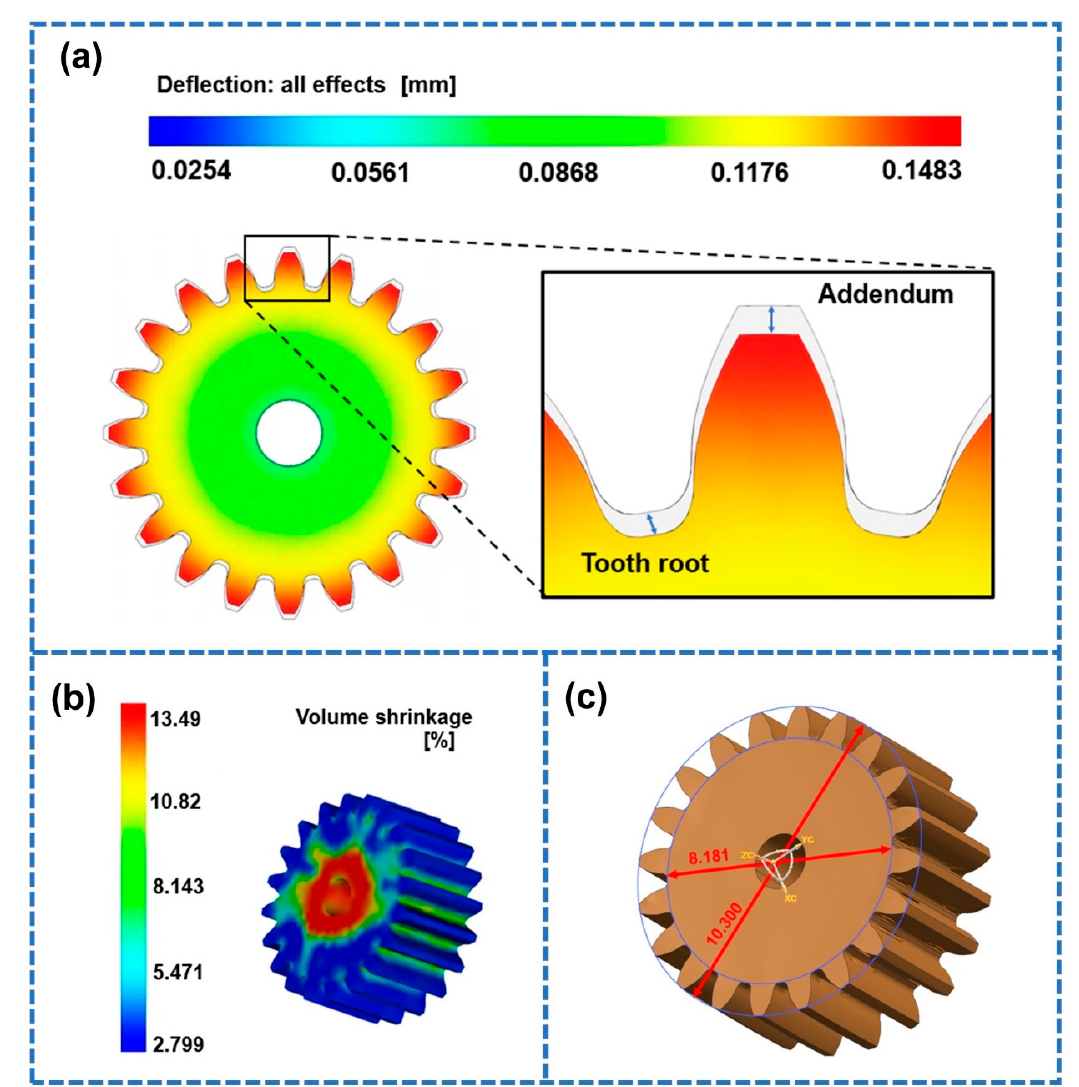
Figure 7. Simulation results under the reference parameters. ( a ) Shrinkage cloud diagram. ( b ) Volume shrinkage. ( c ) Addendum diameter and root circle diameter.